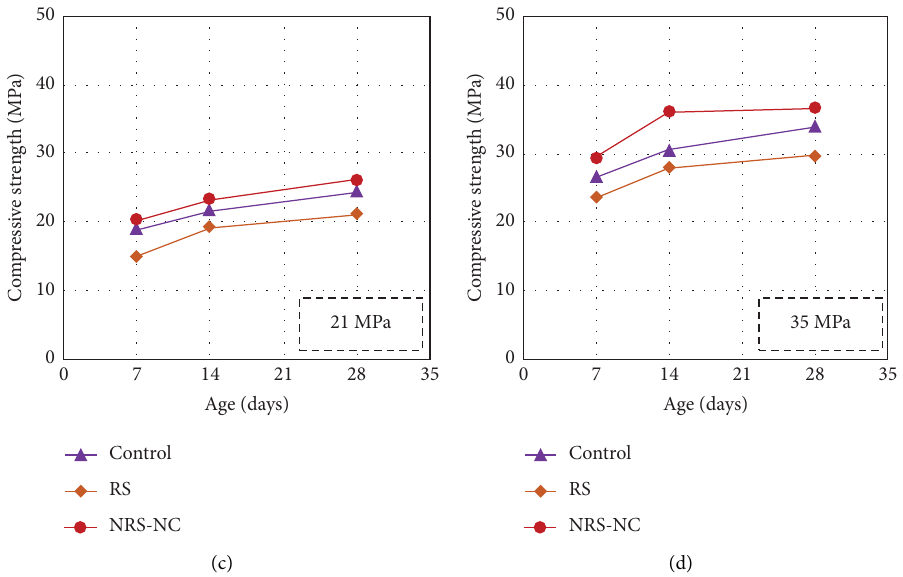
Figure 6: Rate of gain of strength (a) and (b) for 28MPa, (c) for 21MPa, (d) for 35MPa